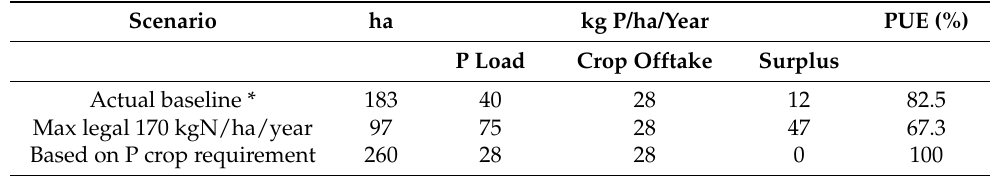
Table 1. P-loading scenarios for the application of pig manure (7300 kg P/year from Figure 5) to different areas of cropland based on the actual baseline case and P crop requirements. PUE calculated using Formula (2).